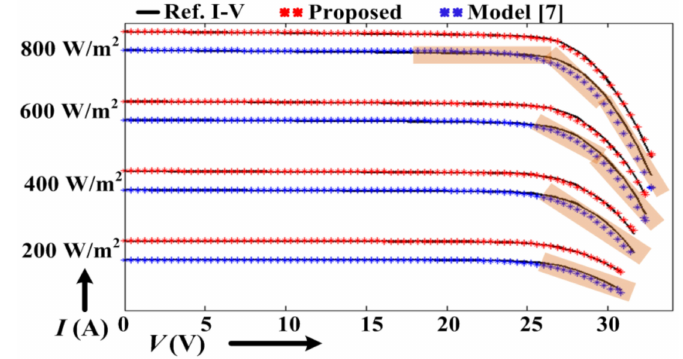
Figure 9. Performance advantage of proposed model over model